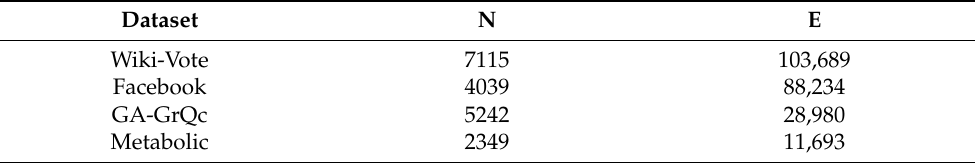
Table 1. Network dataset